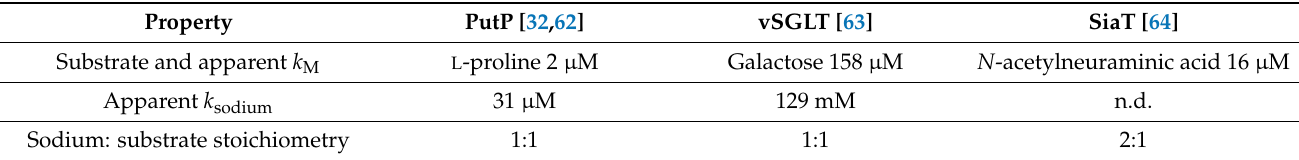
Table 1. Functional properties of PutP, vSGLT, and